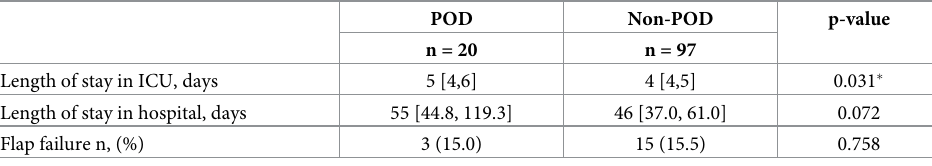
Table 2. Univariate analysis for clinical outcomes between POD group and Non-POD group.